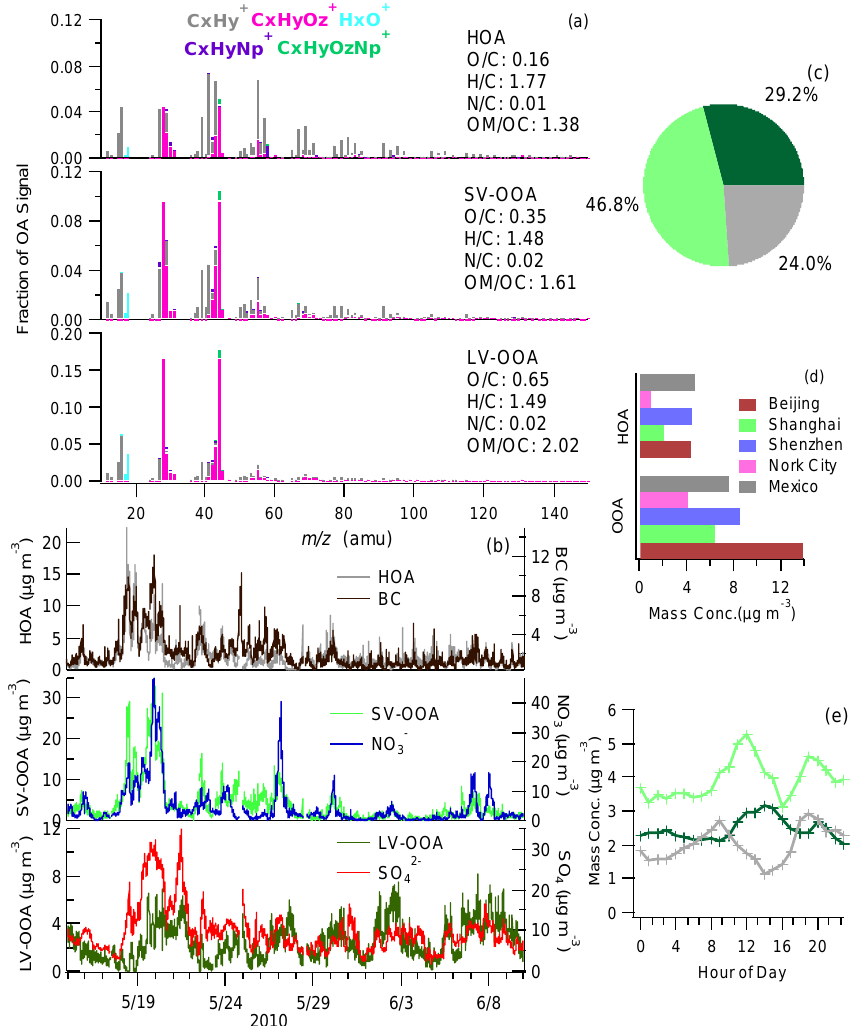
Fig. 4. (a) The MS profiles of the three organic components identified by PMF in this study; (b) time series of the organic components and relevant tracer species; (c) the average organic aerosol composition; (d) the comparison of HOA and OOA concentrations with other mega-cities; and (e) the mean diurnal variations of the organic components.